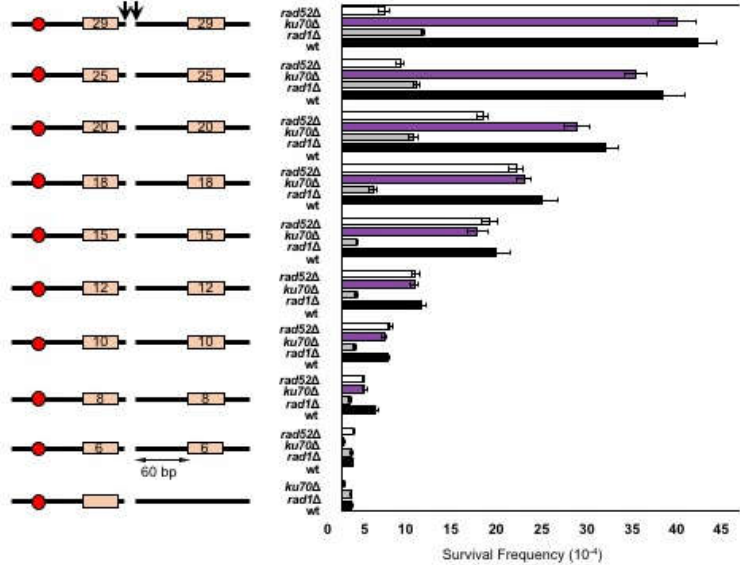
Figure 2. MMEJ requires 8-20 bp microhomology. ( Left ) A diagram of MMEJ reporters with different sizes of microhomology flanking an HO break. The locations of HO cut site (arrow), microhomology (orange boxes), and centromere (red circle) are shown. The size of microhomology is shown in number (bp) inside the microhomology. ( Right ) Graph showing survival frequency ± standard deviation (SD) in wild type (WT), RAD1 Δ (MMEJ deficient mutant), ku70 Δ (C-NHEJ deficient mutant), and RAD52 Δ [homologous recombination ( HR) deficient mutant]. Survival frequency was calculated by dividing the number of colonies surviving on the YEP–GAL plates by the number of colonies surviving on the YEPD plates. The results are the average of three independent experiments.